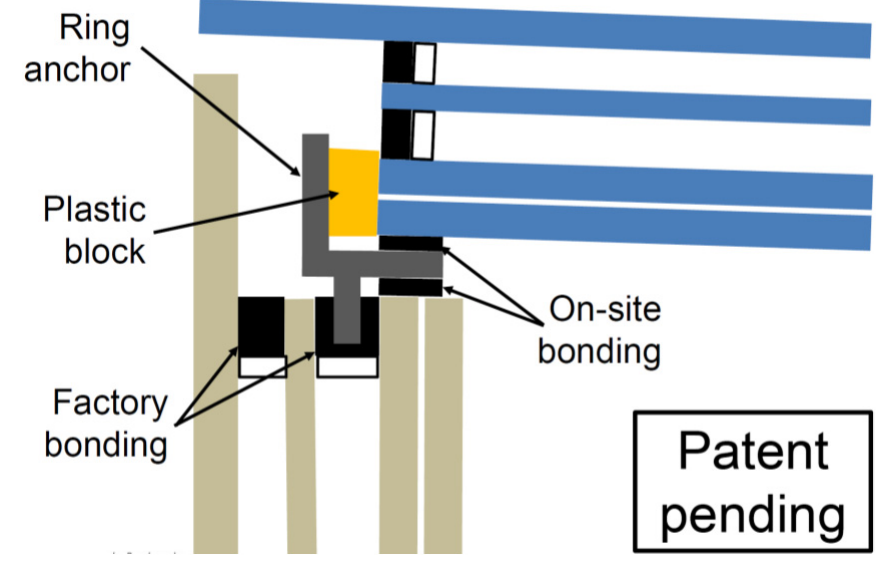
Fig. 4 Section through joint between glass wall and roof